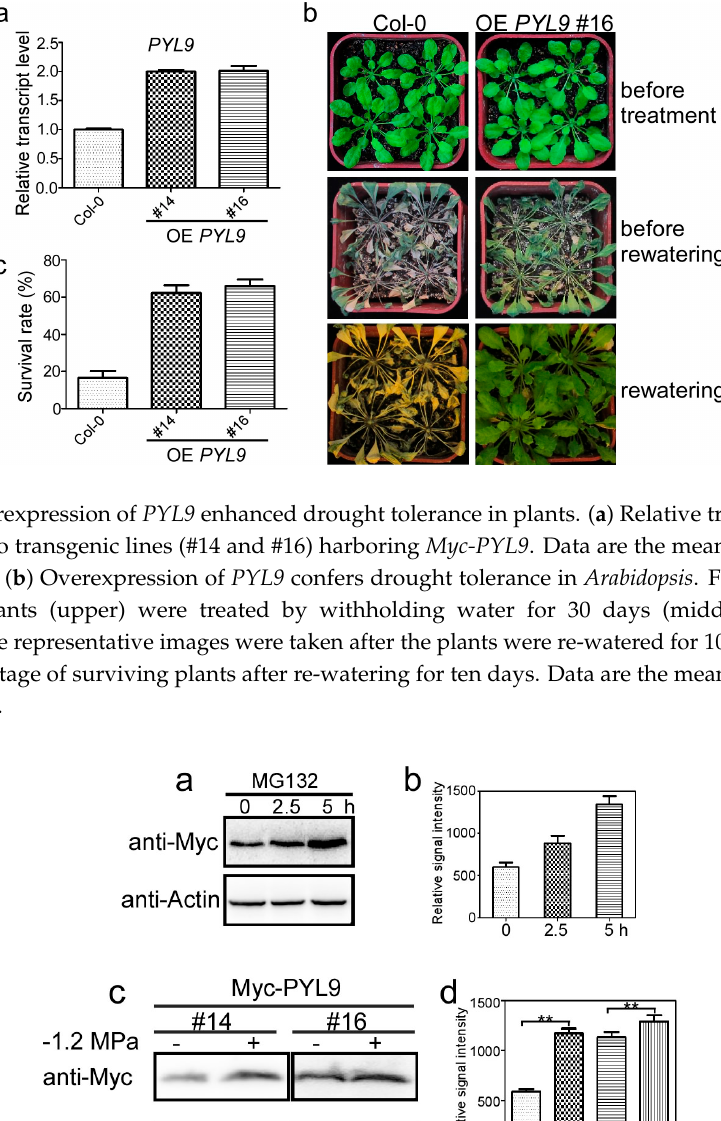
Figure 2. PYL9 was degraded by the 26S proteasome and osmotic stress increased PYL9 accumulation. ( a ) The proteasome inhibitor MG132 stabilized Myc-PYL9. Ten-day-old transgenic seedlings were treated with or without (mock) 50 μ M MG132 for different time period. The bands detected by anti-Actin were used as loading control [44,45]. ( b ) Quantitative evaluation of the Myc-PYL9 protein level in ( a ). Data are the means ± standard errors ( n = 3). ( c ) Osmotic stress increased the accumulation of Myc-PYL9. Seedlings of two T 3 transgenic lines (#14 and #16) were grown on − 1.2 MPa PEG-infused plates for three hours. The bands detected by anti-Actin were used as loading control. ( d ) Quantitative evaluation of the Myc-PYL9 protein level in ( c ). Independent experiments were repeated three times with the similar results. Data are the means ± standard errors ( n = 3). Asterisks indicate significant differences ( p < 0.05).